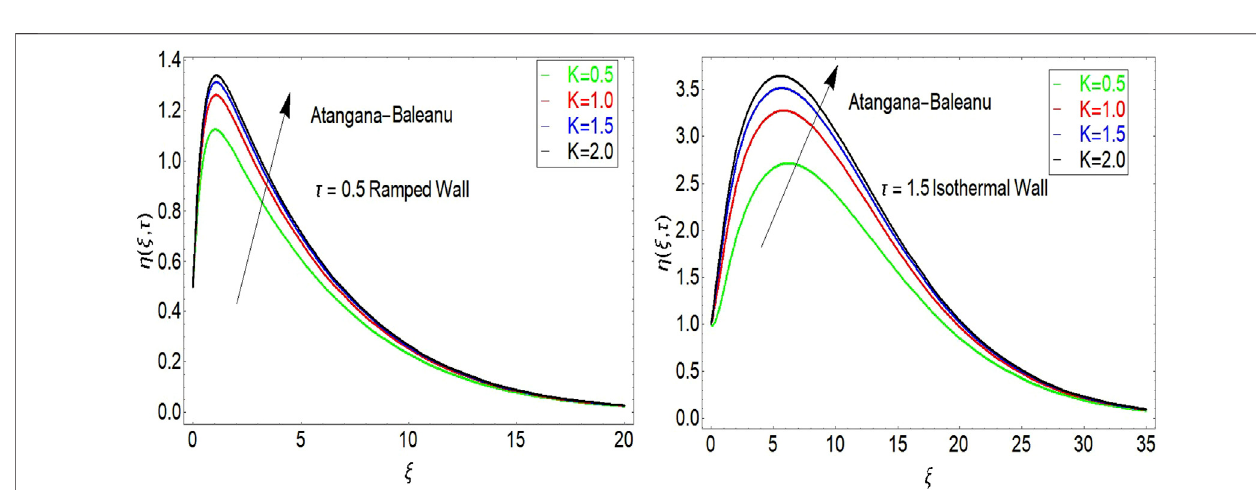
FIGURE 5 | In fl uence of K on velocity for constant and ramped temperature.